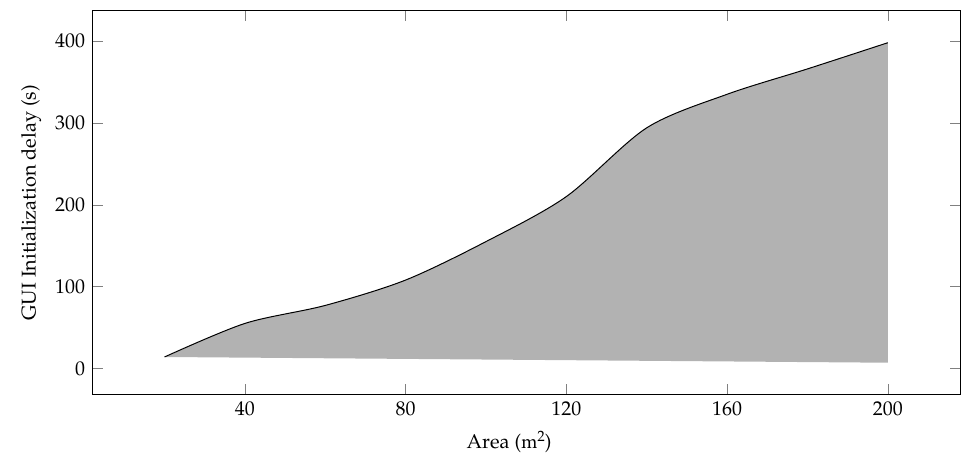
Figure 2. Component initialization delay in GUI mode.